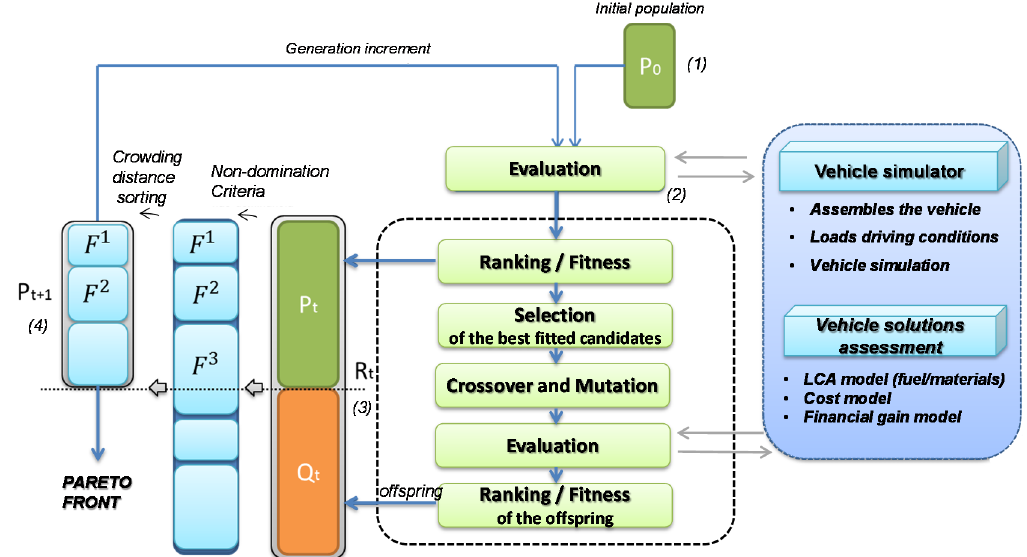
Figure 3. Implementation of the NSGA-II including its integration with ADVISOR platform, LCA calculations and cost